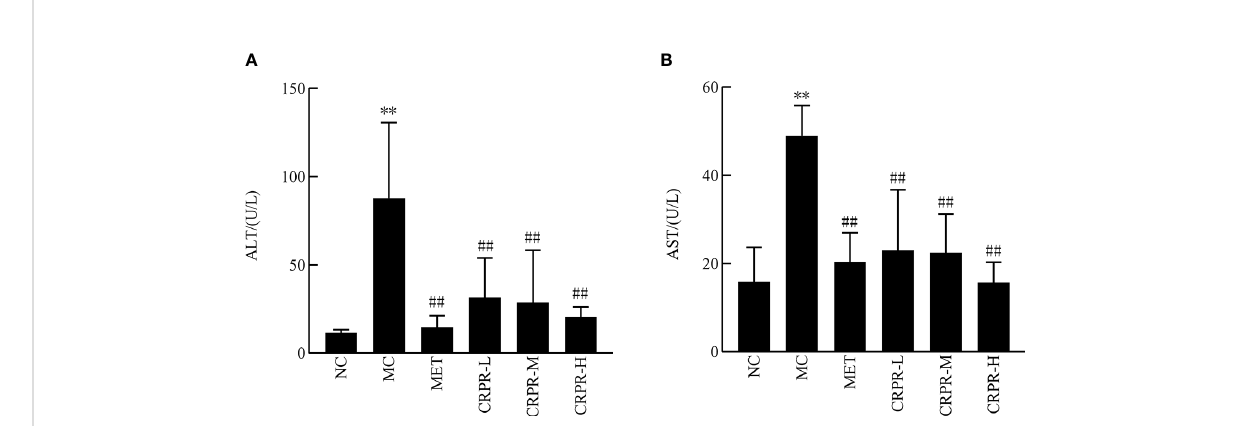
FIGURE 3 Effect of CRPR on liver function in T2DM mice. (A) Effect of CRPR on ALT. (B) Effect of CRPR on AST. All values are presented as the mean ± SD. ** P <0.01 vs. the NC group; ## P <0.01 vs. the MC group.